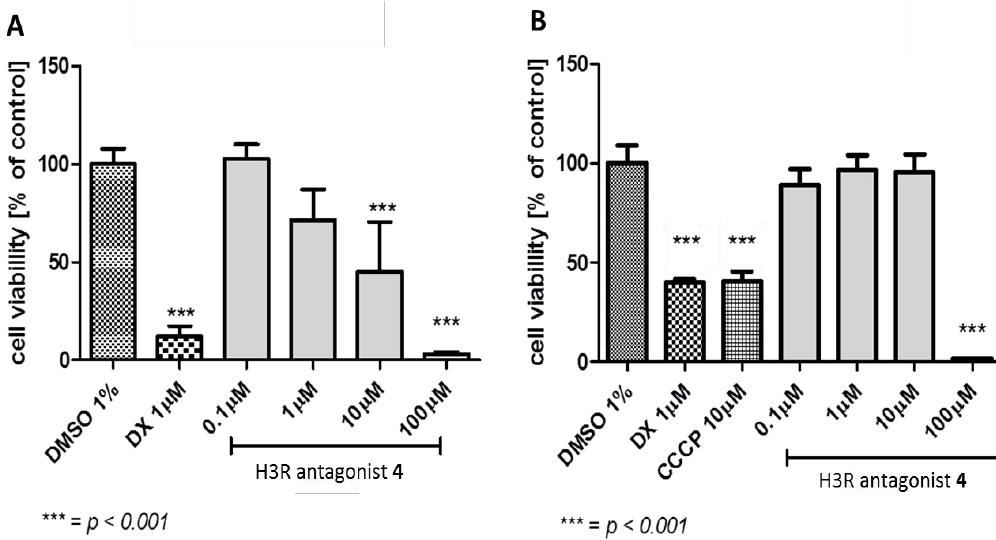
Figure 4. Antiproliferative effects of H3R antagonist 4 . ( A ) Antiproliferative effects of the reference drug doxorubicin (DX) and H3R antagonist 4 on HEK-293 cell line after 72 h of incubation. ( B ) Antiproliferative effects of the reference drug doxorubicin (DX), hepatotoxin carbonyl cyanide 3-chlorophenylhydrazone (CCCP), and H3R antagonist 4 on HepG2 cell line after 72 h of incubation. DMSO: dimethyl sulfoxide.